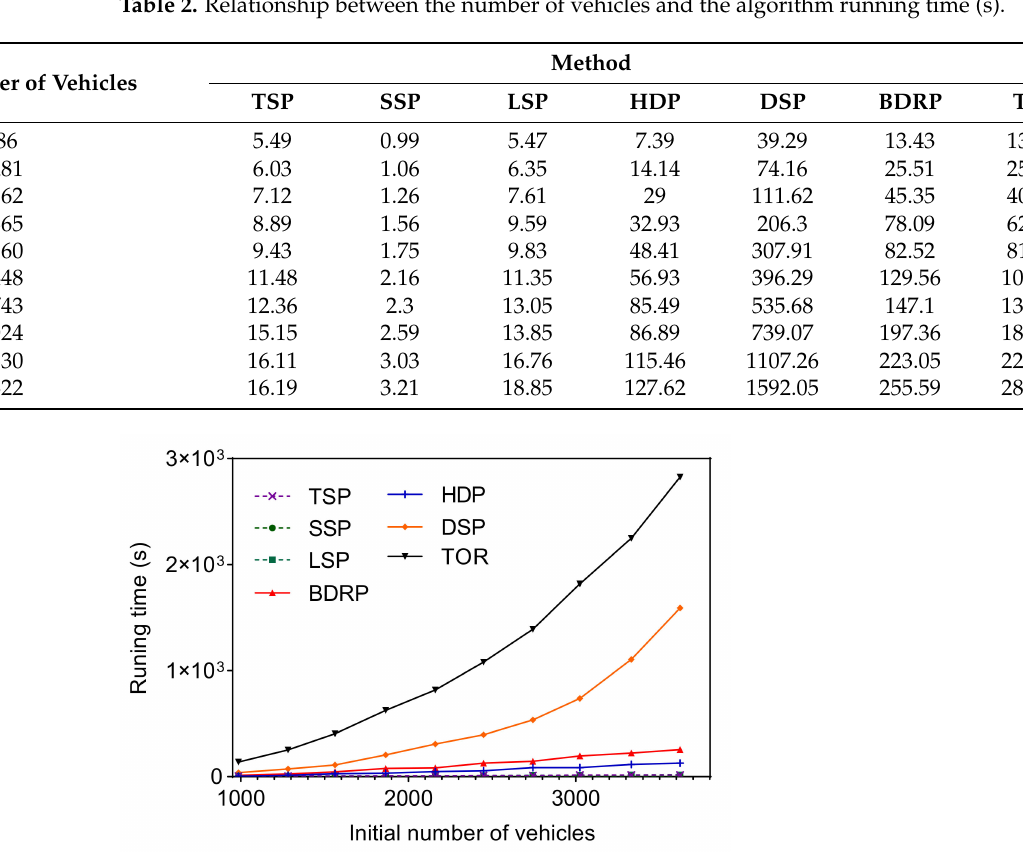
Figure 6. Algorithm running time comparison under different initial number of